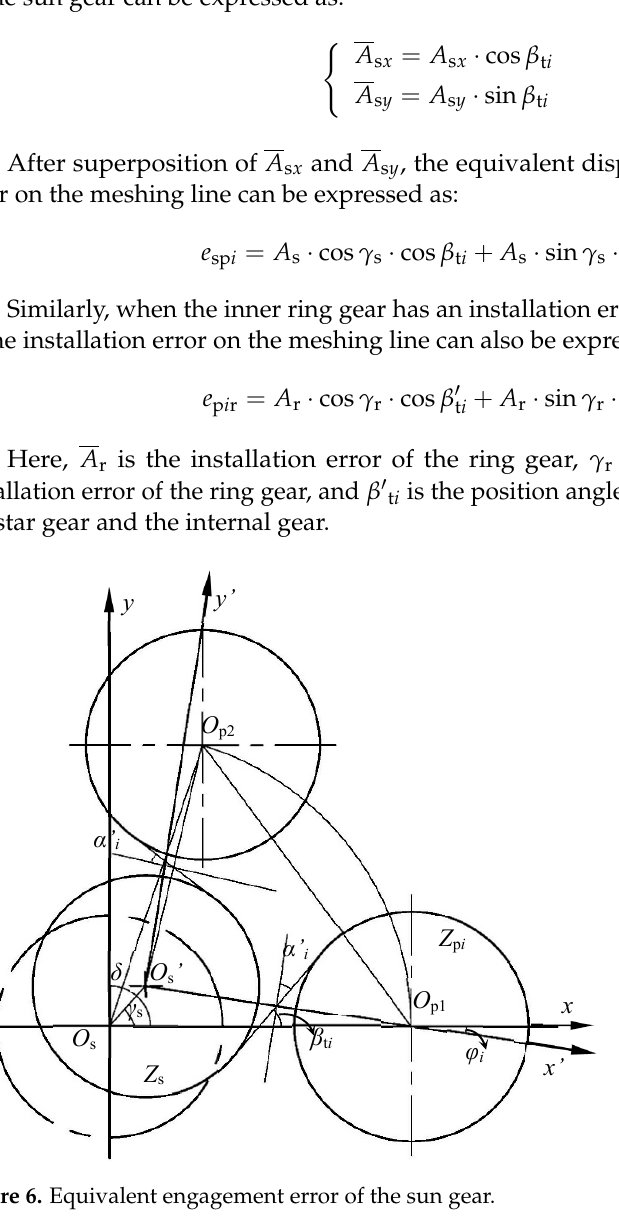
Table 1. Basic parameters of herringbone tooth star gear train in a GTF.